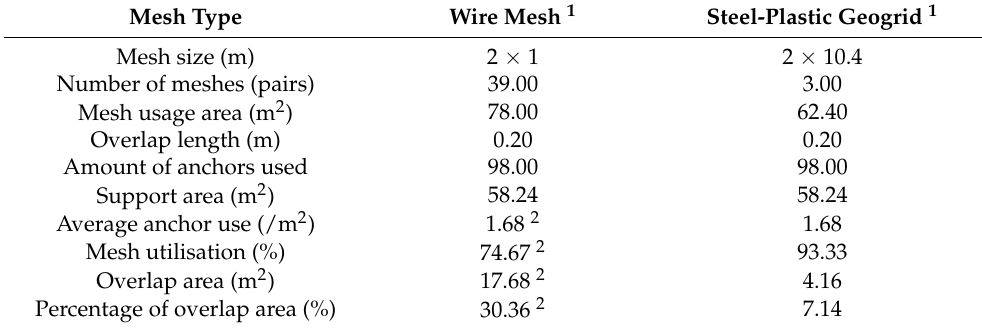
Table 5. Statistical table of profile spread data.